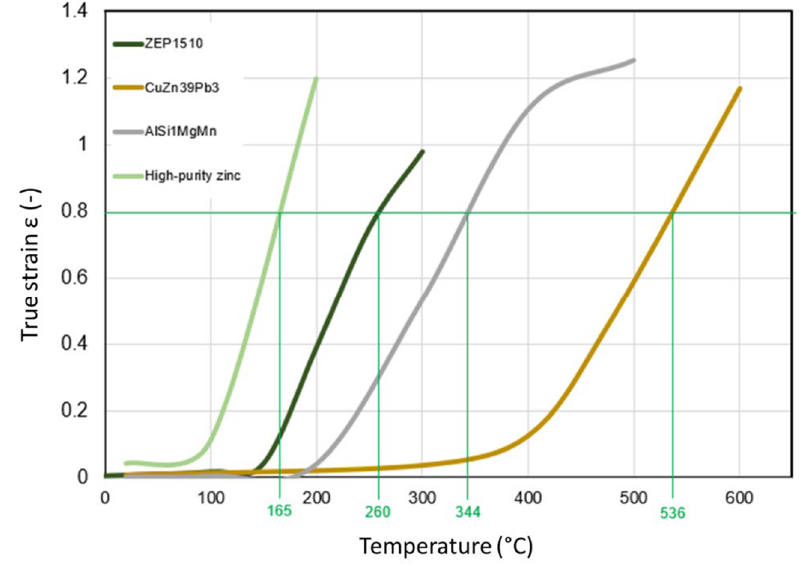
Figure 3. Formability of high-purity zinc, ZEP1510, AlSi1MgMn, and CuZn39Pb3 as a function of temperature.